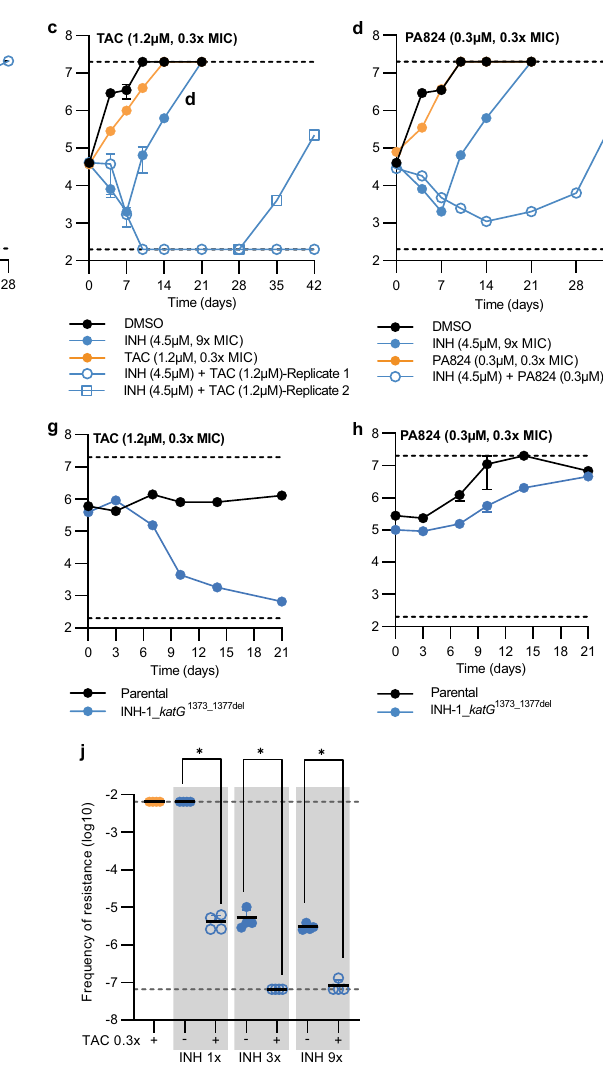
Fig. 6 | Drug combinations that exploit collateral drug sensitivities delay the emergence of isoniazid resistance in vitro. a – d Drug-susceptible M. tuberculosis was incubated with either INH at 9x the MIC, below MIC concentrations (i.e. 0.3× MIC of the drug-susceptible parent) of a second compound being either Q203, BDQ, TAC, PA824,or a combination of INH (9× MIC) and the second compound at concentrations below the MIC. e – h Time kill assays of selected INH-1 and drug- susceptible parent against sub-inhibitory concentrations (0.3× MIC). CFUs were determined on the stated days. i , j Frequency of resistance of drug-susceptible parent strain when challenged with antibiotics at various concentrations (single or in combination). For i , statistical signi fi cance was investigated using a one-way ANOVA, and corrected for multiple comparisons using the Dunnett ’ s multiple